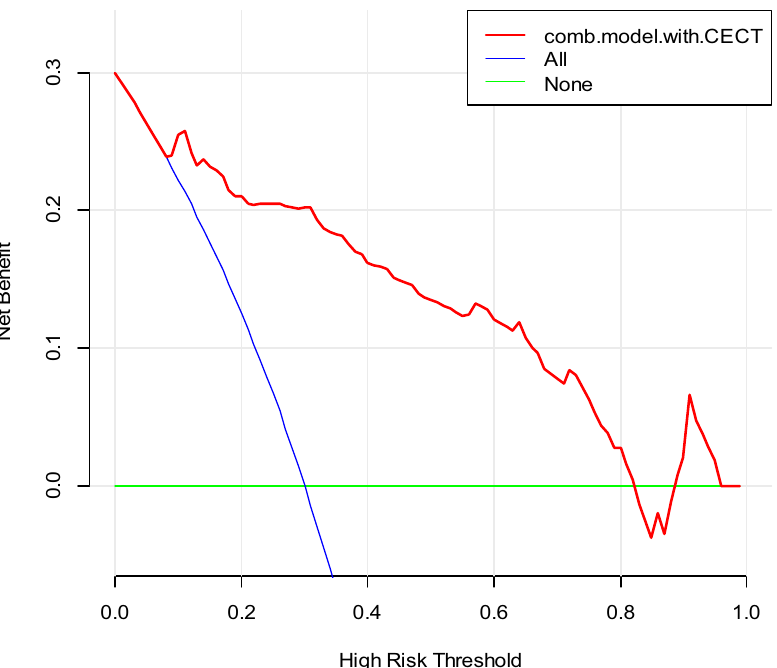
Figure 5. DCA for the individualized prediction nomogram. The y-axis represented the net benefit. The red line represented the nomogram. The blue line represented the hypothesis that all patients with subcentimeter GGNs were invasive lesions. The green line represented the hypothesis that all patients with subcentimeter GGNs were preinvasive lesions. The x-axis represented the threshold probability.